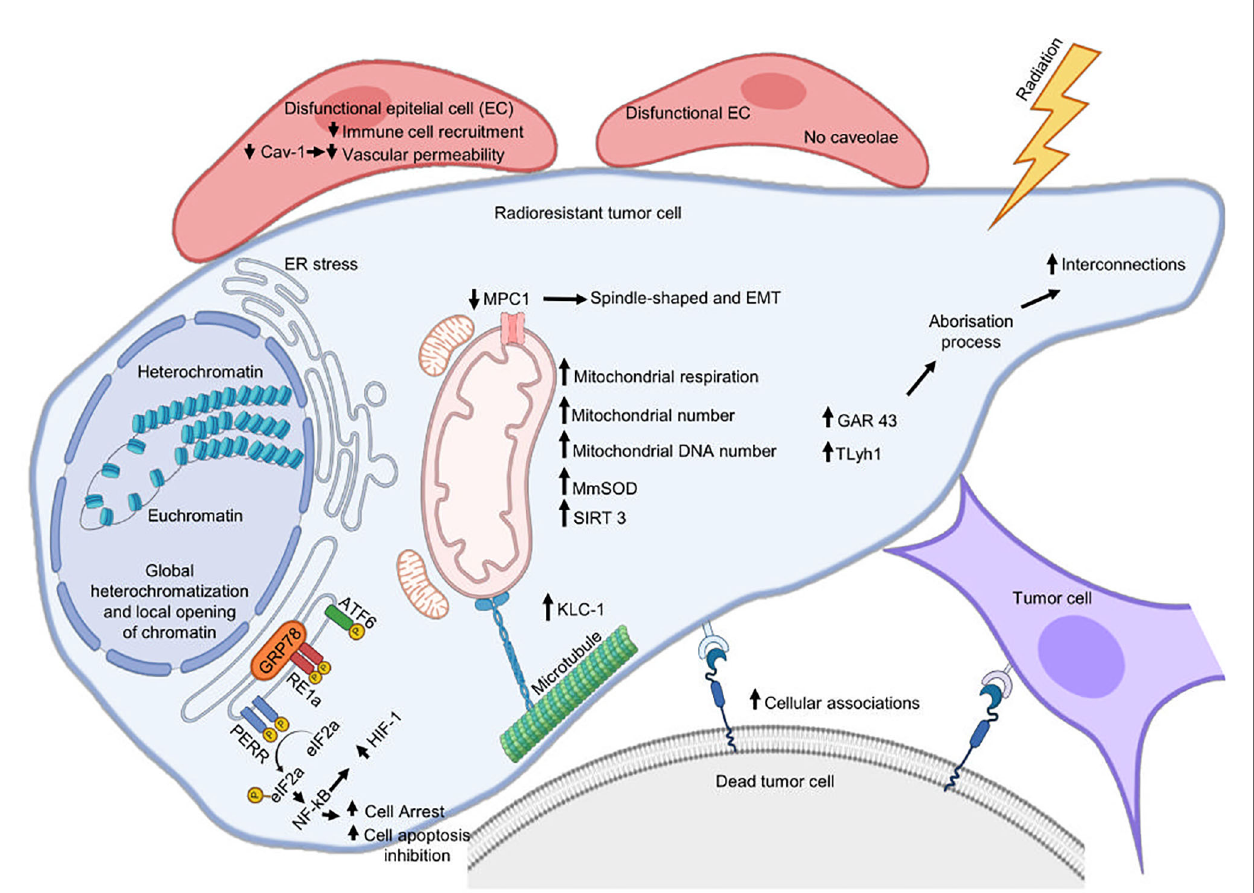
FIGURE 2 | Cellular mechanisms associated with radioresistance. Cytoplasmic membrane, reticulum endoplasmic, and mitochondria are the main organelles where tumor cells assemble a response to develop radioresistance. Radiation can damage the endoplasmic reticulum (ER) homeostatic state and cause ER stress that will favor radioresistance. This last is also supported by mitochondrial alterations, metabolic remodeling, and by an increase in plasma membrane interconnections favoring the formation of cytoplasmic bridges. Cetuximab promotes radioresistance involving ERS pathway IRE1 a /ATF6-GRP78. Silencing GRP78 inhibits the cooperative effects of radiotherapy and cetuximab inhibiting DSB repair and autophagy in OPCC. IRE1 promotes radioresistance in HPV-negative OPCC through IL- 6 activation. Decreased MPC1 expression favors EMT and promotes radioresistance of